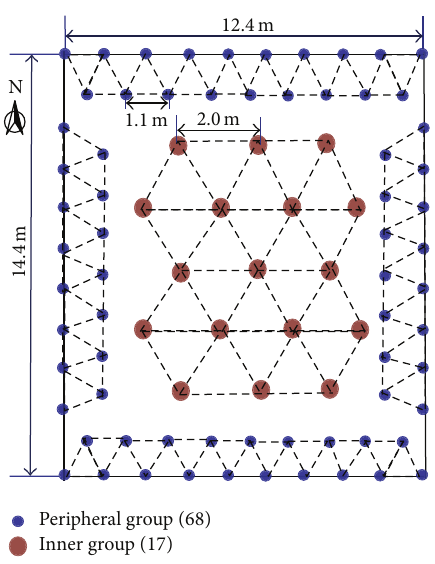
Figure 6: Distribution of